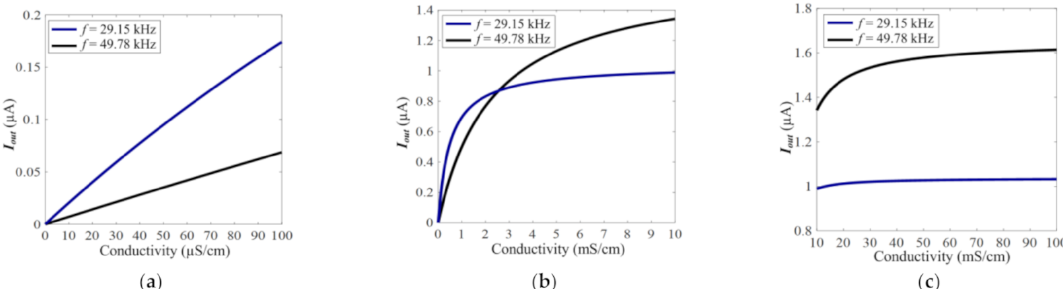
Figure 8. The theoretical curves of Equation (5) which show the complex relationship between I out and σ . ( a ) The detailed theoretical curves of Equation (5) under the conductivity range of 1–100 µ S/cm. ( b ) The detailed theoretical curves of Equation (5) under the conductivity range of 100 µ S/cm–10 mS/cm. ( c ) The detailed theoretical curves of Equation (5) under the conductivity range of 10–100 mS/cm. Notations: The values of L and C 3 are set as the same as the practical C 4 D sensor. R L is set as 2200 and 1200 Ω , respectively. C e is set as 0.6